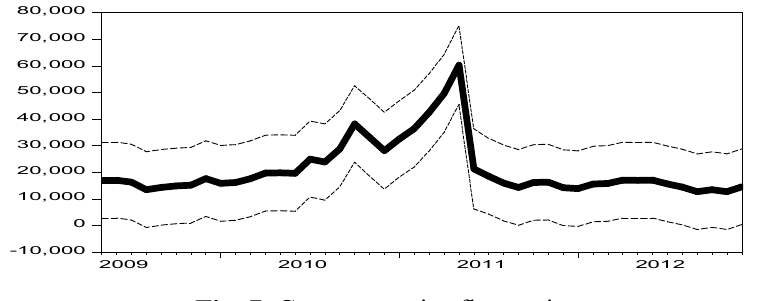
Fig. 7. Computer price fluctuation